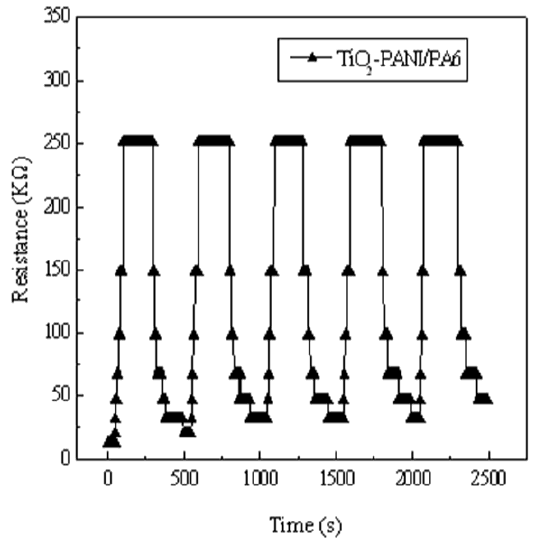
-PANI/PA6 to ammonia vapor of 250 ppm. 2